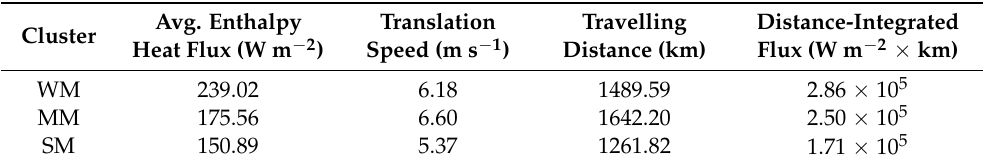
Table 2. Comparisons of the averaged flux, translation speed, moving distance, and distance-integrated flux for three cluster TCs in three days before landfall.